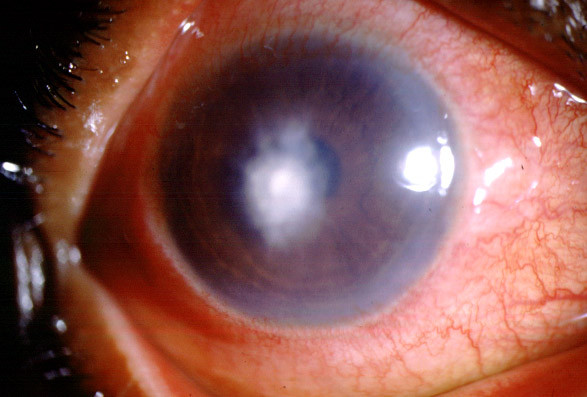
Slit lamp biomicroscopy of cornea of case 1 in diffuse illumination with central mid to deep stromal infiltrate and surrounding stromal edema.